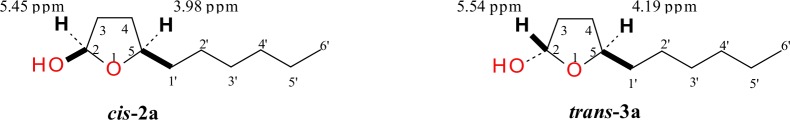
Space structures and chemical shifts of signals from protons H-2 and H-5 in hemiacetals 2a and 3a.